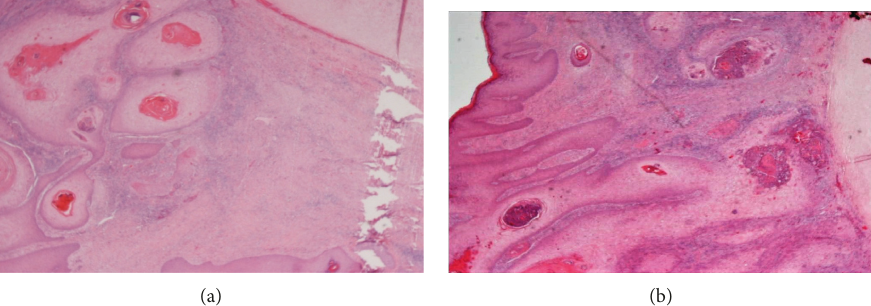
Figure 8: Photomicrograph of excised ulcerative, crusted lesion (H&E stain). This demonstrates moderately differentiated SCC. (a) × 10 magnification. (b) × 2.5